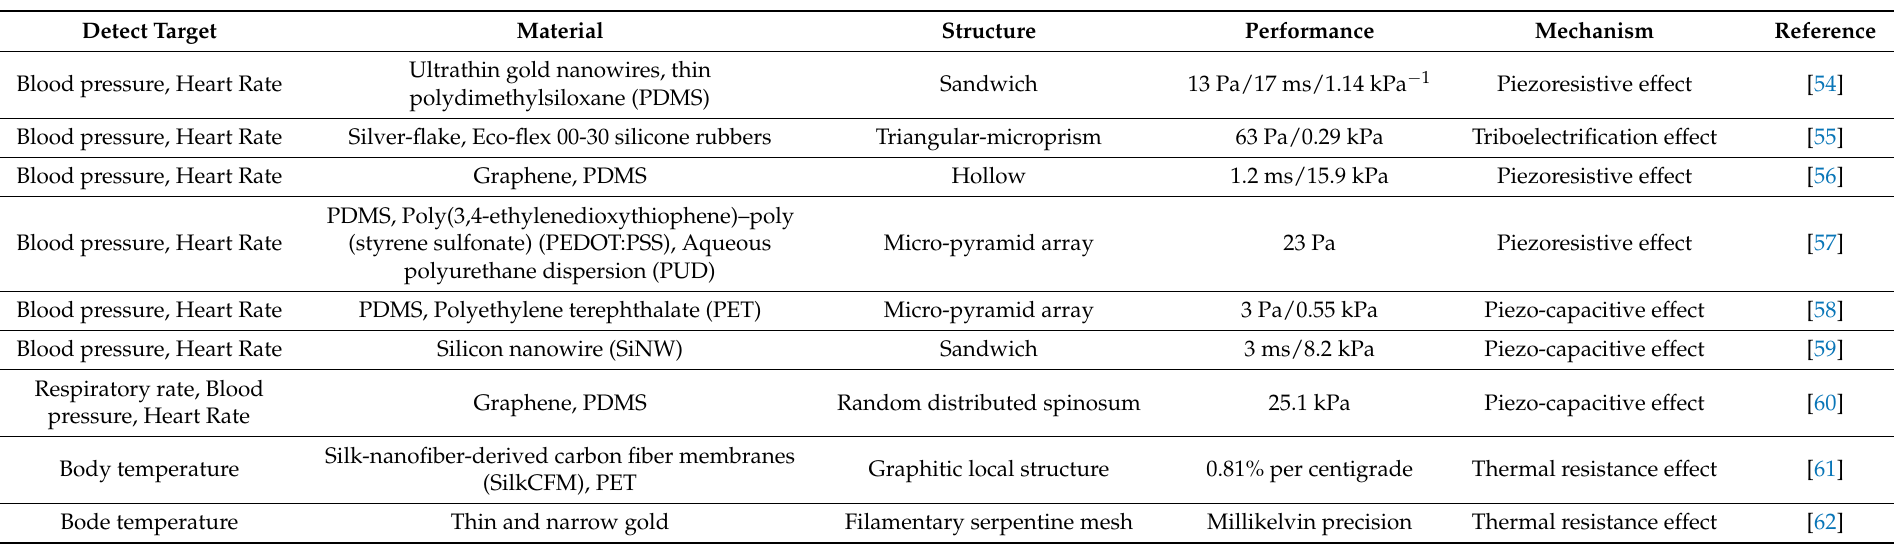
Table 2. Summary of tattoo for vital health signs